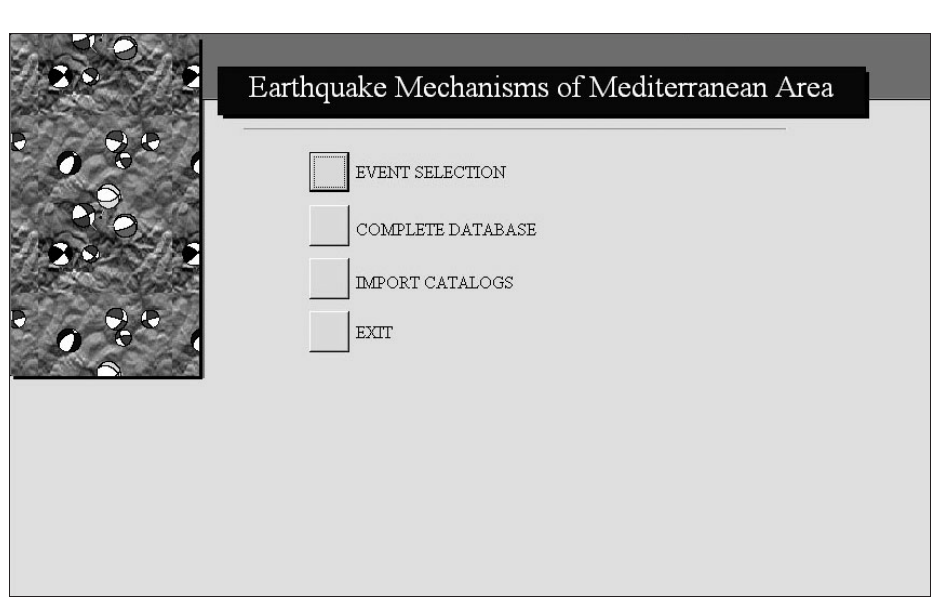
Fig. 2. Main menu of EMMA database.